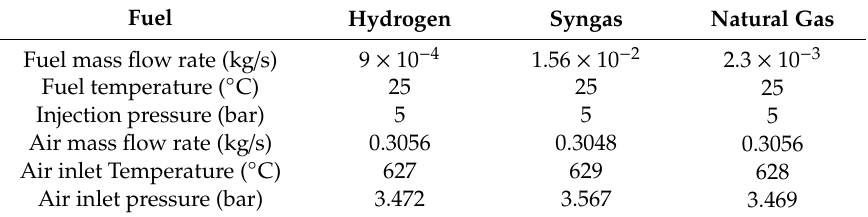
Table 8. Boundary